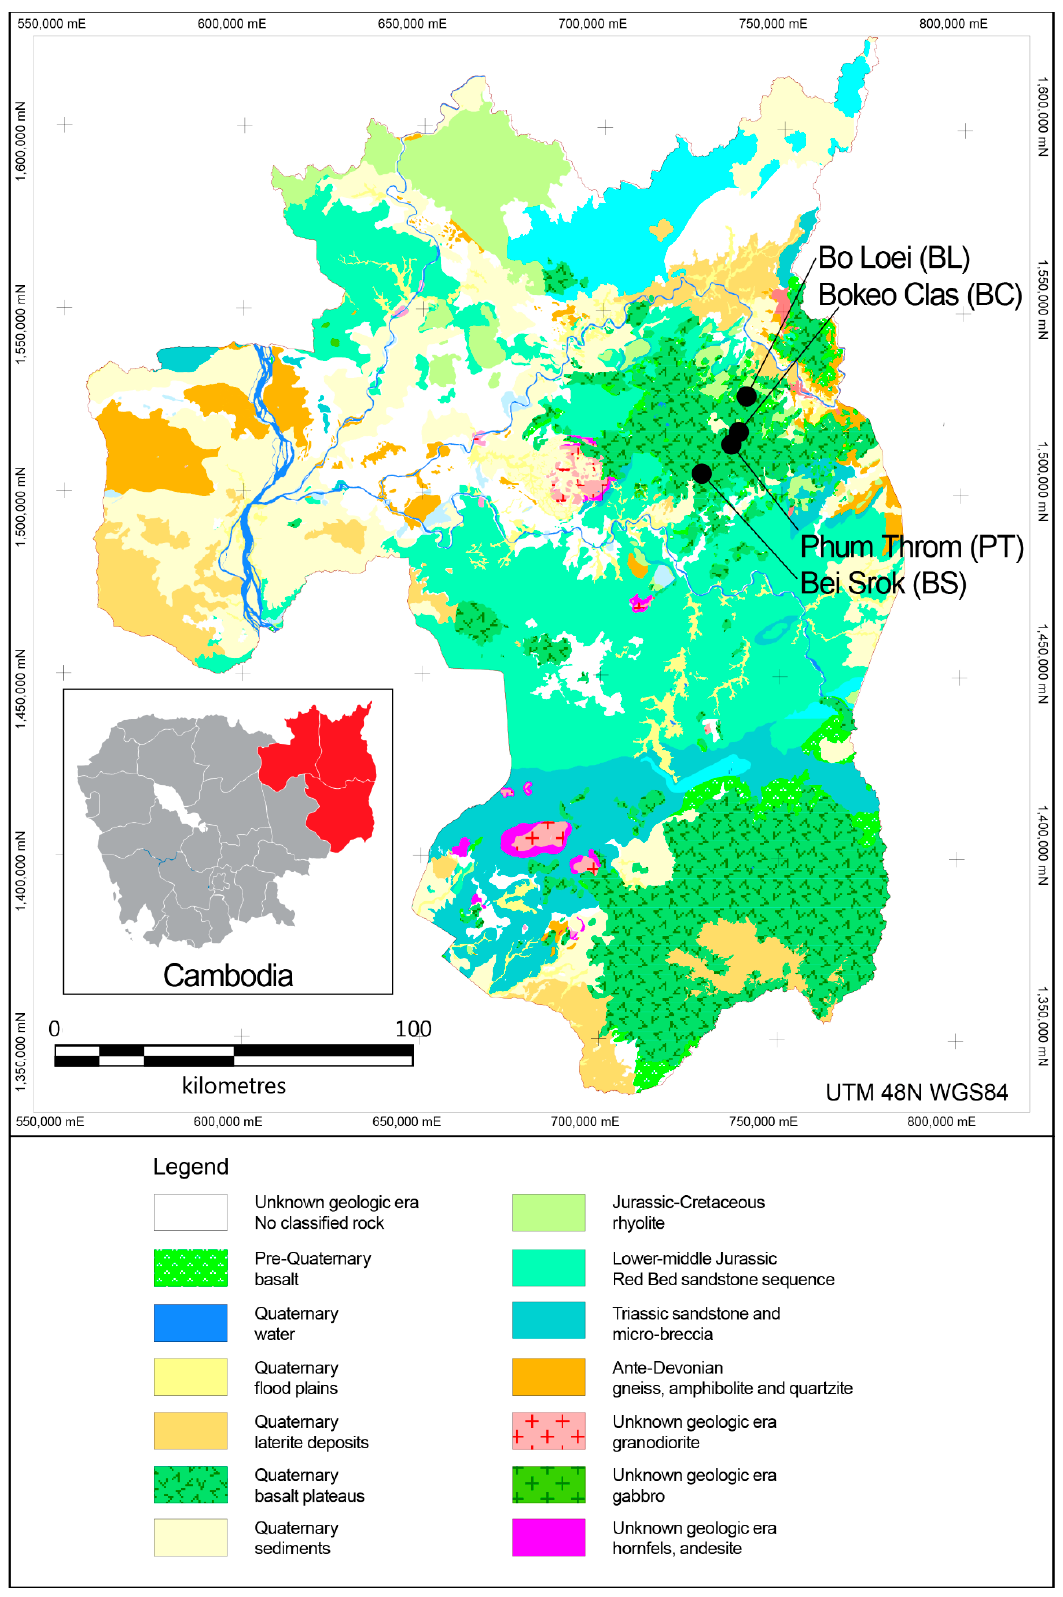
Figure 4. Geological map of Stung Treng, Ratanakiri, and Mondulkiri provinces, Northeast Cambodia. The Ratanakiri Volcanic Province (RVP) and Ban Chay Plateau Quaternary basalts are indicated in green with hatching. Zircon xenocryst localities (black dots) include Bokeo Clas (BC), Phum Throm (PT), Bei Srok (BS), and Bo Loei (BL).